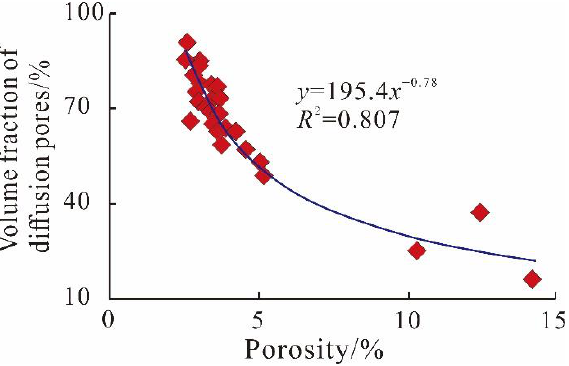
Figure 13. Relationship between porosity and volume fraction of diffusion pores.